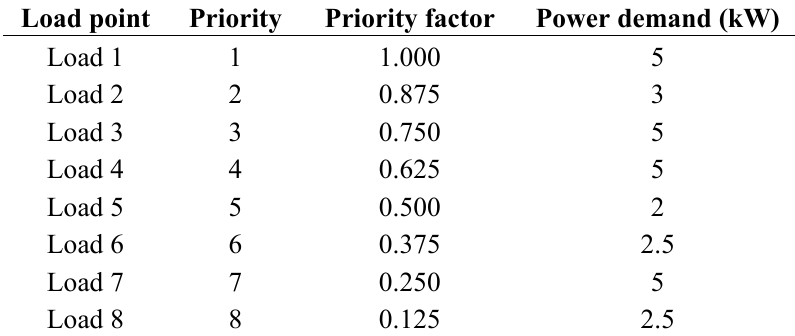
Table 1. The settings of loads in the local